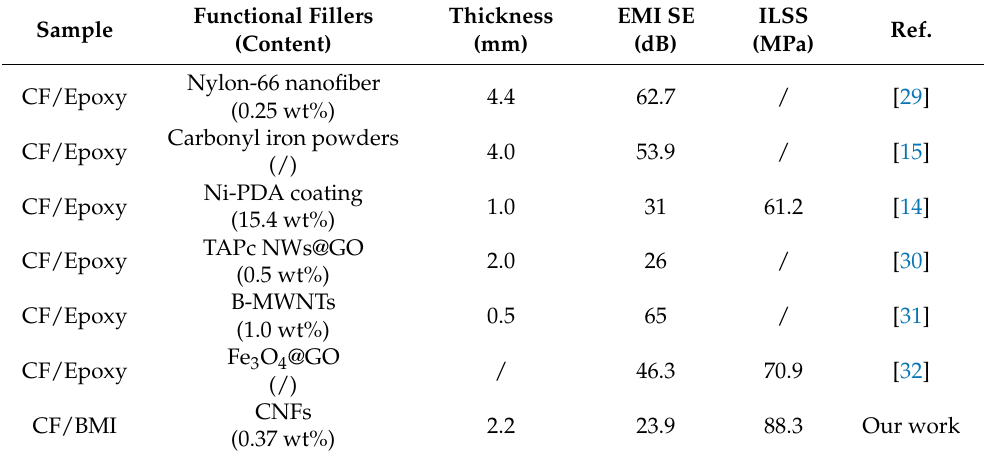
Table 1. Comparison of EMI SE and ILSS of the recently reported CF reinforced composites.